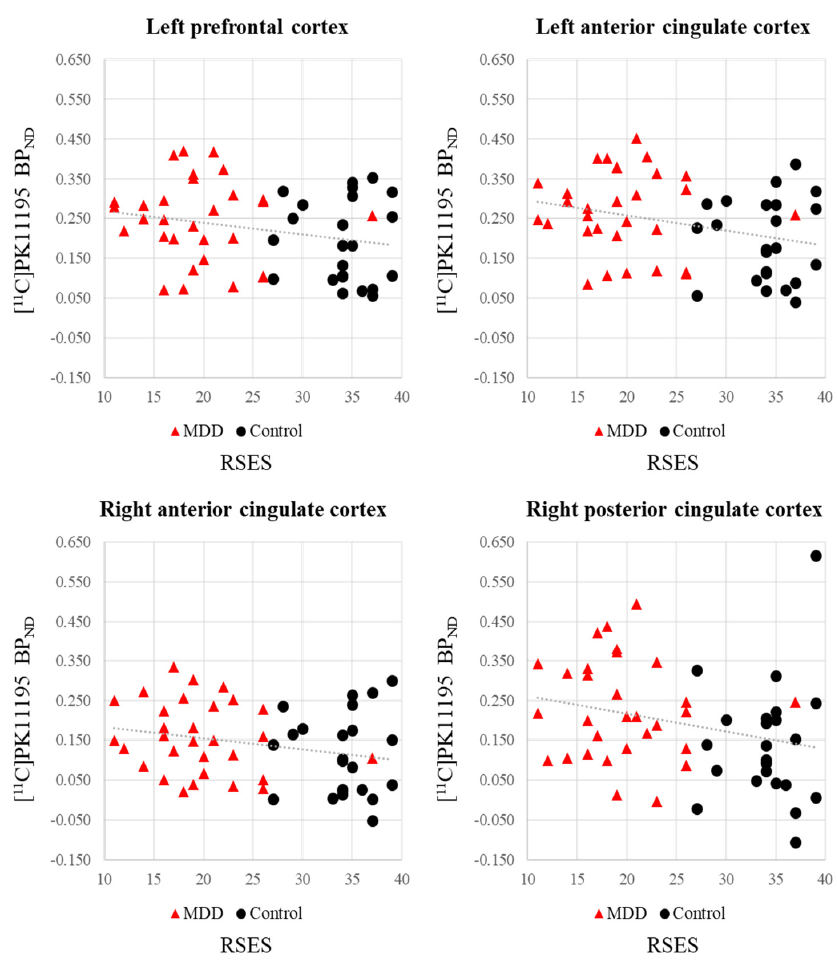
Figure 3. Scatter plots of the correlation between [ 11 C]PK11195 BP ND values and RSES scores for the entire subject group ( n = 53). The RSES score had a significant negative correlation with the [ 11 C]PK11195 BP ND in the left anterior cingulate cortex ( r = − 0.301, p = 0.029) and tended to have negative correlations with the [ 11 C]PK11195 BP ND in the left prefrontal ( r = − 0.242, p = 0.081), right anterior cingulate ( r = − 0.248, p = 0.074), and right posterior cingulate ( r = − 0.269, p = 0.052) cortices. BP ND , binding potential with respect to non-displaceable compartment; MDD, major depressive disorder; RSES, Rosenberg Self-Esteem Scale. Table 4. Correlation coefficients between regional [ 11 C]PK11195 BP ND values and serum adiponectin levels with BMI as a covariate and between-group comparisons of the correlation coefficients. ROIs